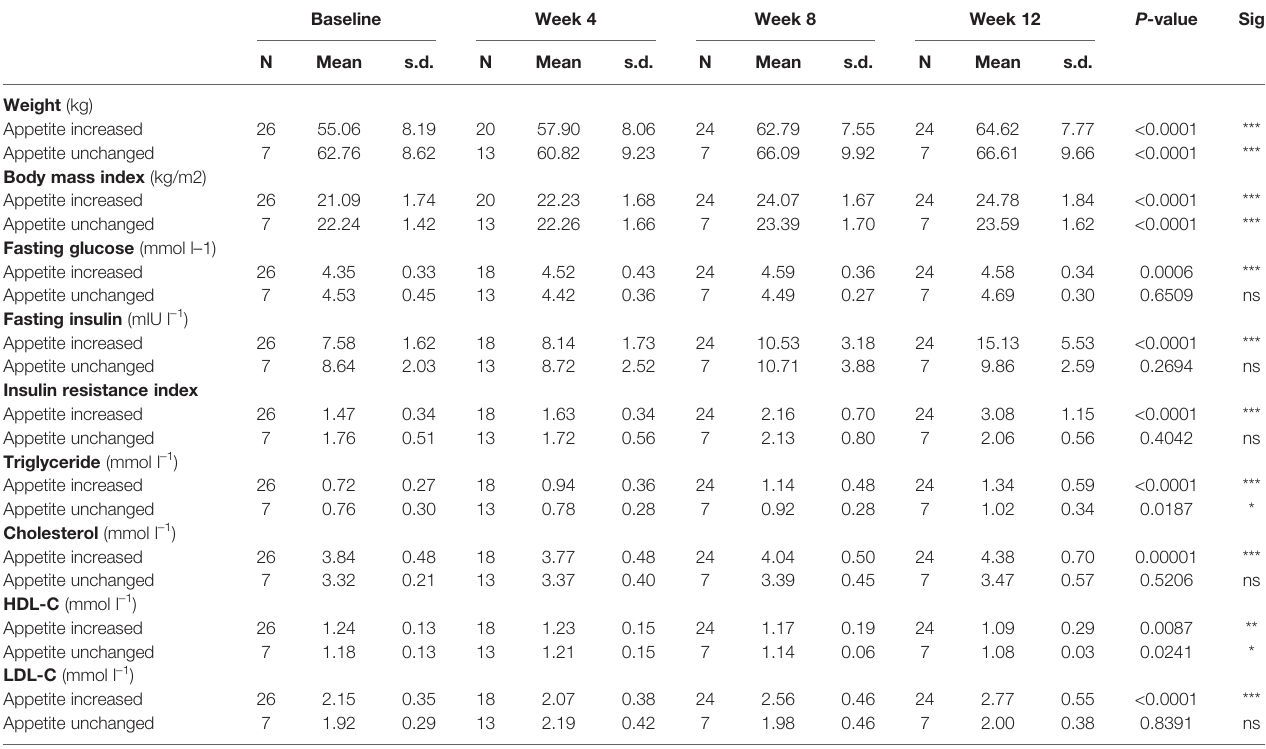
TABLE 2 | Descriptive statistics of outcome measures between increased and unchanged appetite groups at baseline, and weeks 4, 8, and 12. Baseline